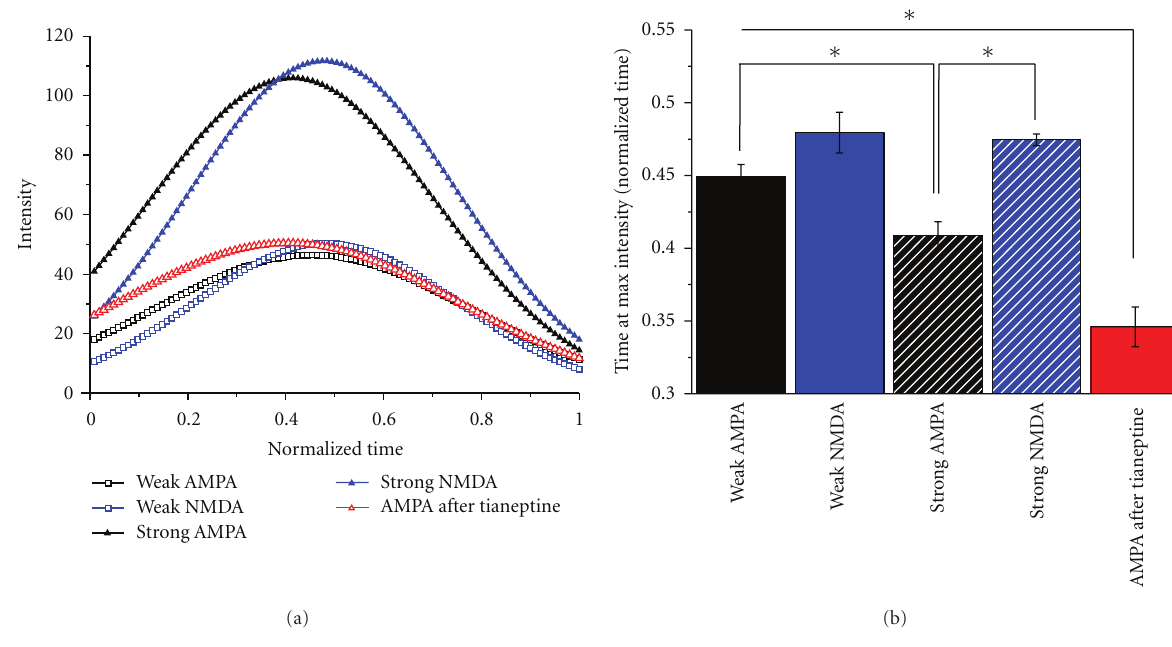
Figure 3: Temporal evolution of spiking dynamics. The time courses of discharge trains were normalized, and a parabola was fitted onto the 1/ISI values (a). Note that the maximal intensity is attained for both AMPA and NMDA excitation regardless of the strength, which happens later than in the AMPA after tianeptine scenario (b). Asterisks denote significant di ff erences at P ≤ 0 .